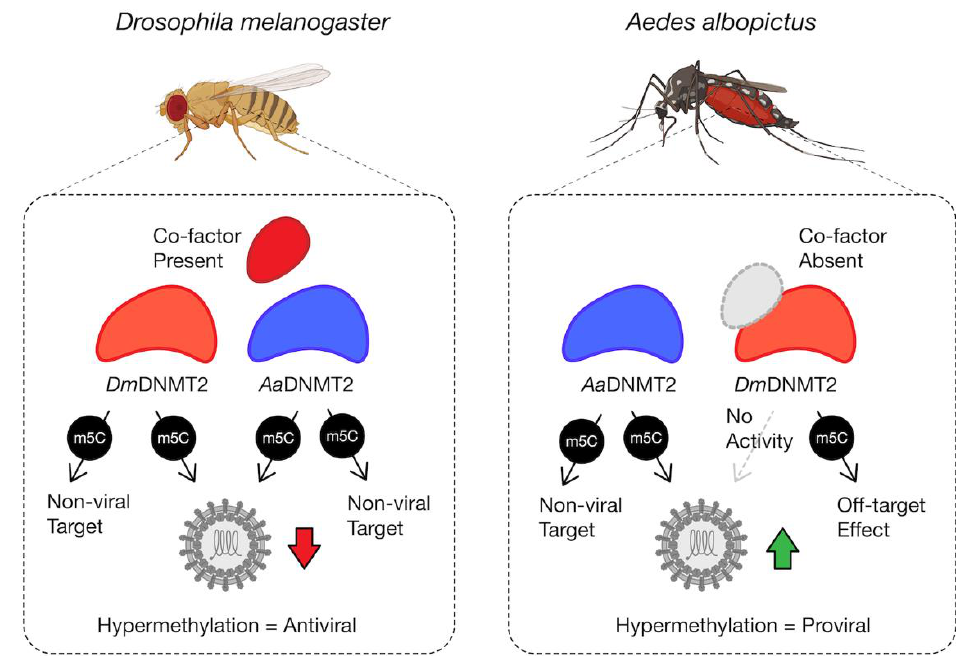
Figure 6. Model schematic of Dm DNMT2 and Aa DNMT2 activity. Heterologous expression of either Dm DNMT2 or Aa DNMT2 in Drosophila melanogaster- derived JW18 cells leads to virus inhibition, likely as a consequence of hypermethylation of a viral and/or host target. In this case, Dm DNMT2 function is potentially aided by the presence of an unidentified co-factor. Heterologous expression of Aa DNMT2 in Wolbachia- colonized Aedes albopictus cells leads to the rescue of virus inhibition, likely due to hypermethylation of a viral and/or host target. In contrast, Dm DNMT2 expression in these cells has no observable effect on virus replication, suggesting either a loss in MTase activity or potential off-target effects. This result could be due to the absence of Dm DNMT2 ′ s cognate interaction partner(s) or co-factor(s) unique to Drosophila and are thus absent in Aedes albopictus cells.